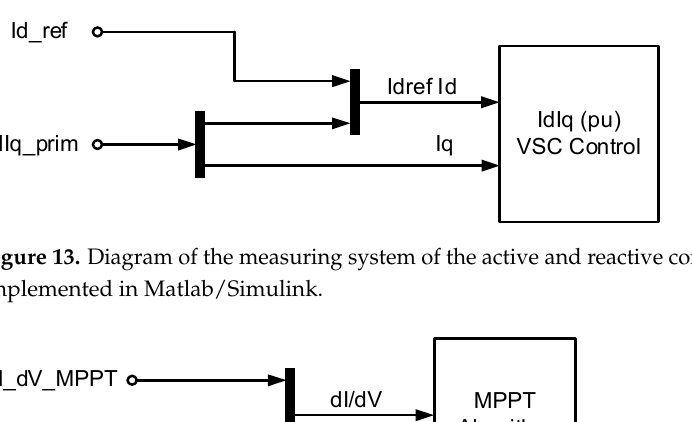
Figure 12. Diagram of the measuring system of parameters of photovoltaic modules implemented in Matlab/Simulink.